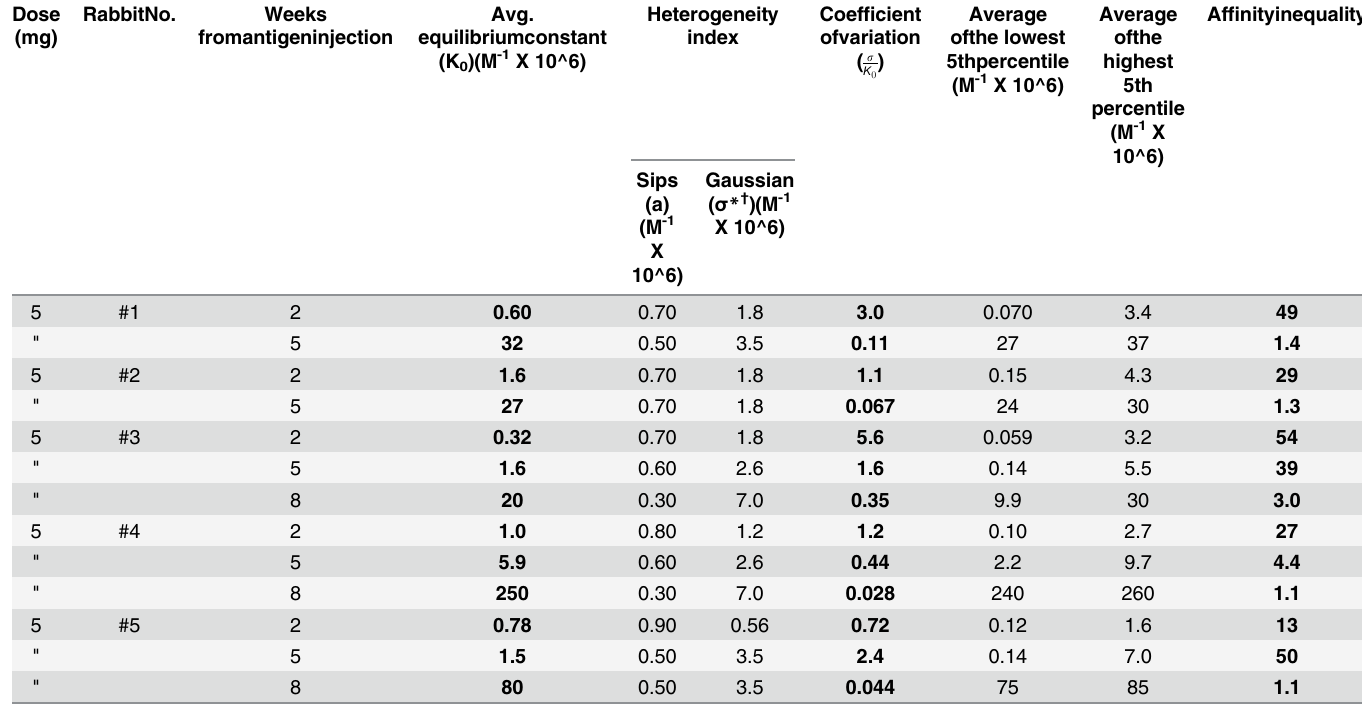
Table 1. Affinity inequality of antibodies after single injection of 5mg dose of the immunogen in rabbits. Dose (mg)